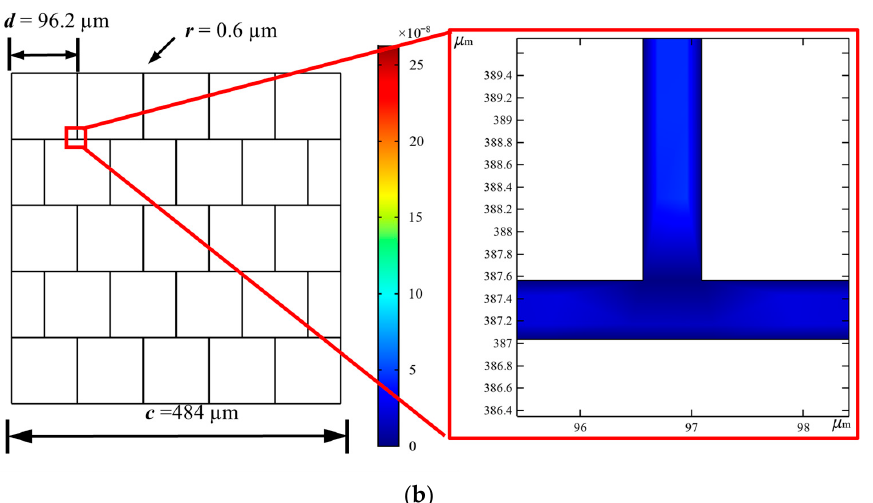
Figure A1. COMSOL model diagram using Katsumi’s experimental data [6]. ( a ) I = 0.2 mol/L; n f = 0.011; ( b ) I = 0.25 mol/L; n f = 0.012.